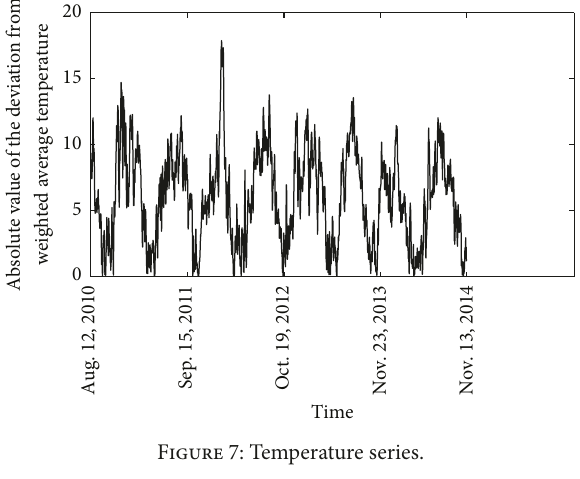
Figure 7: Temperature series.